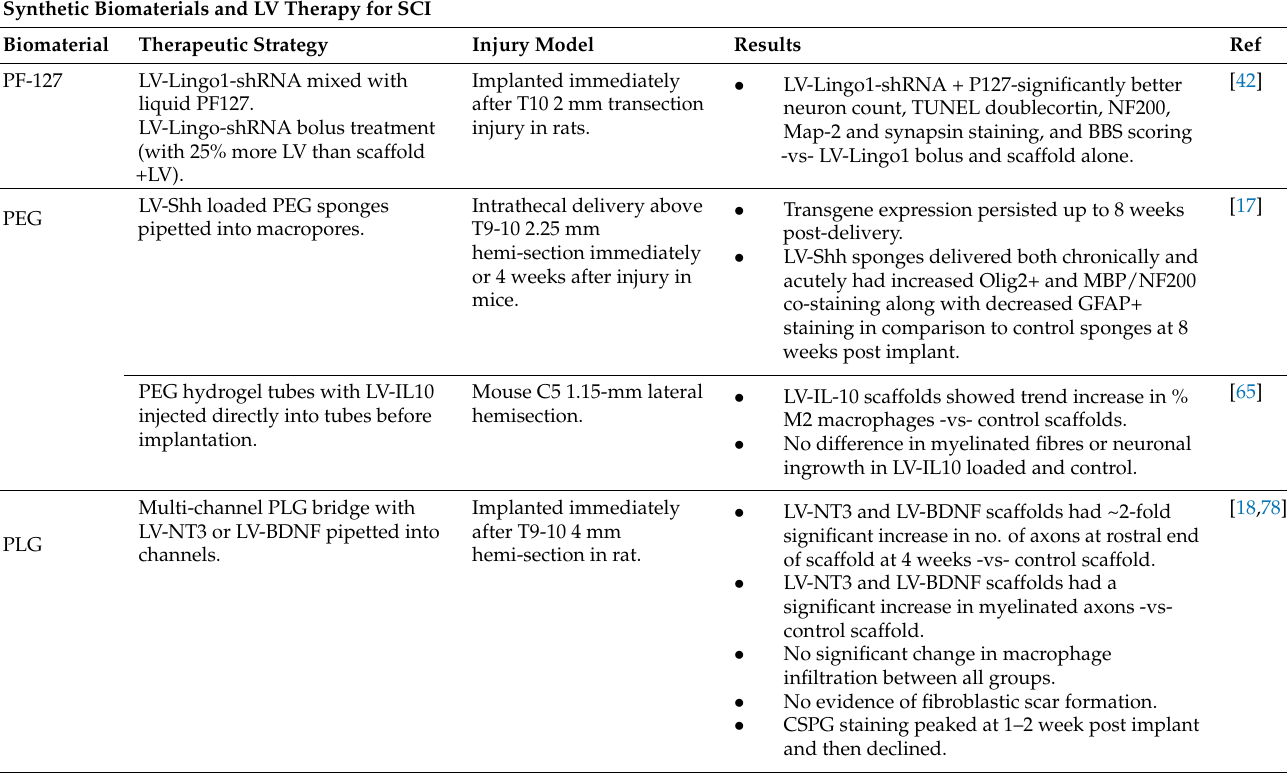
Table 7. Studies combining LVs with Synthetic biomaterials for SCI regeneration. BBS; Berg Balance Scale, MBP; myelin basic protein, NF200; Neuron filament protein 200, PEG. Polyethylene (glycol), PF-127; Pluronic F-127, F4/80+ macrophages; pro-regenerative macrophage, IL-10; interleukin-10, PDGF; Platelet derived growth factor, PLG; poly(lactide-co-glycolide), NT3; Neurotrophin 3, Shh; Sonic hedgehog